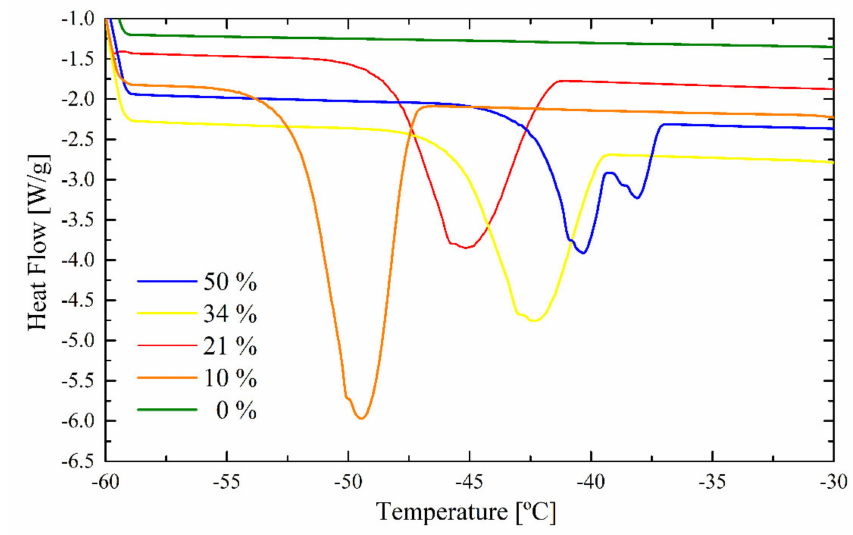
Figure 10. DSC peaks for bound freezing of the ITA